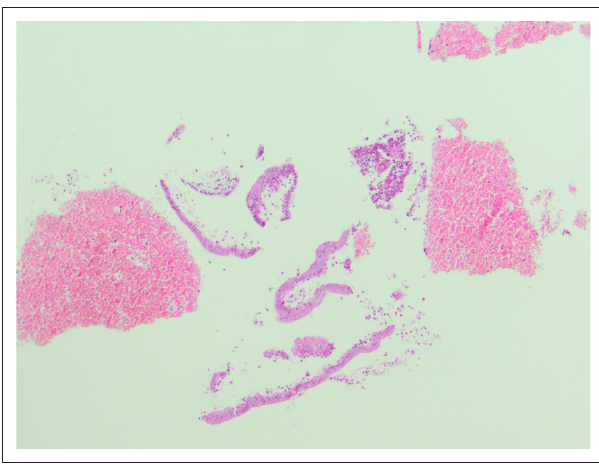
FIGURE 1: Endometrial sample showing limited endometrial tissue comprising less than 10 endometrial strips (original magnification